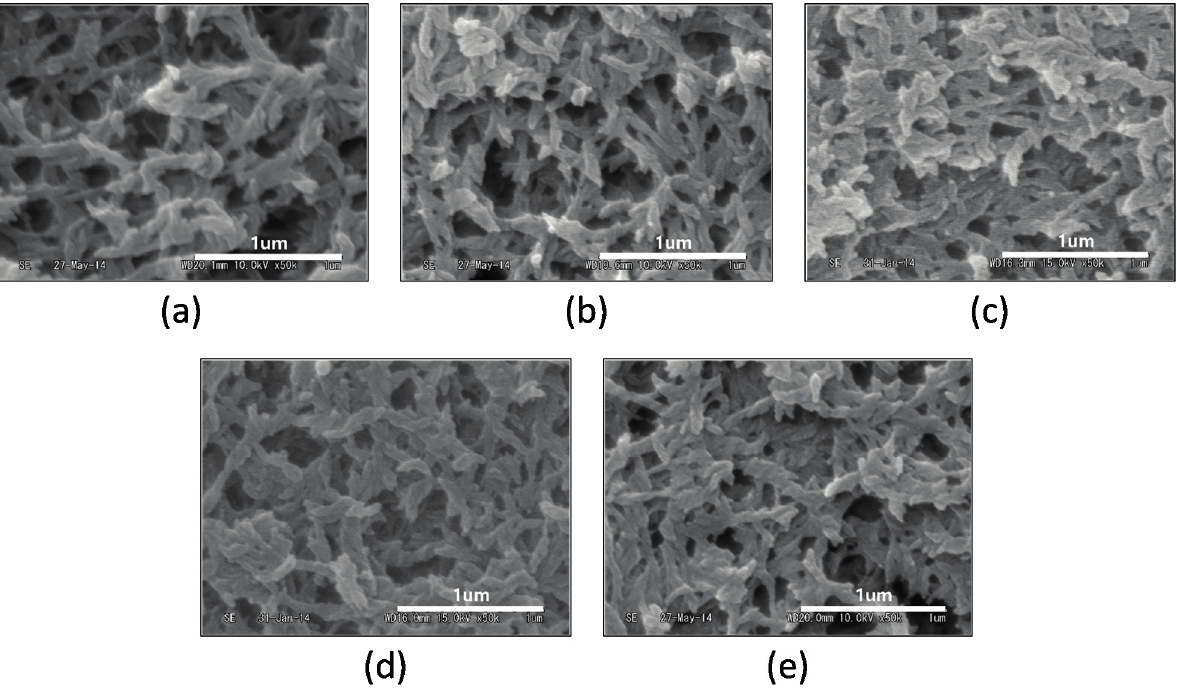
Figure 7. FE-SEM images of the polymer/ChLC nano-composites with different chiral dopant concentrations: ( a ) 6 wt %; ( b ) 7 wt %; ( c ) 8 wt %; ( d ) 9 wt %; ( e ) 10 wt